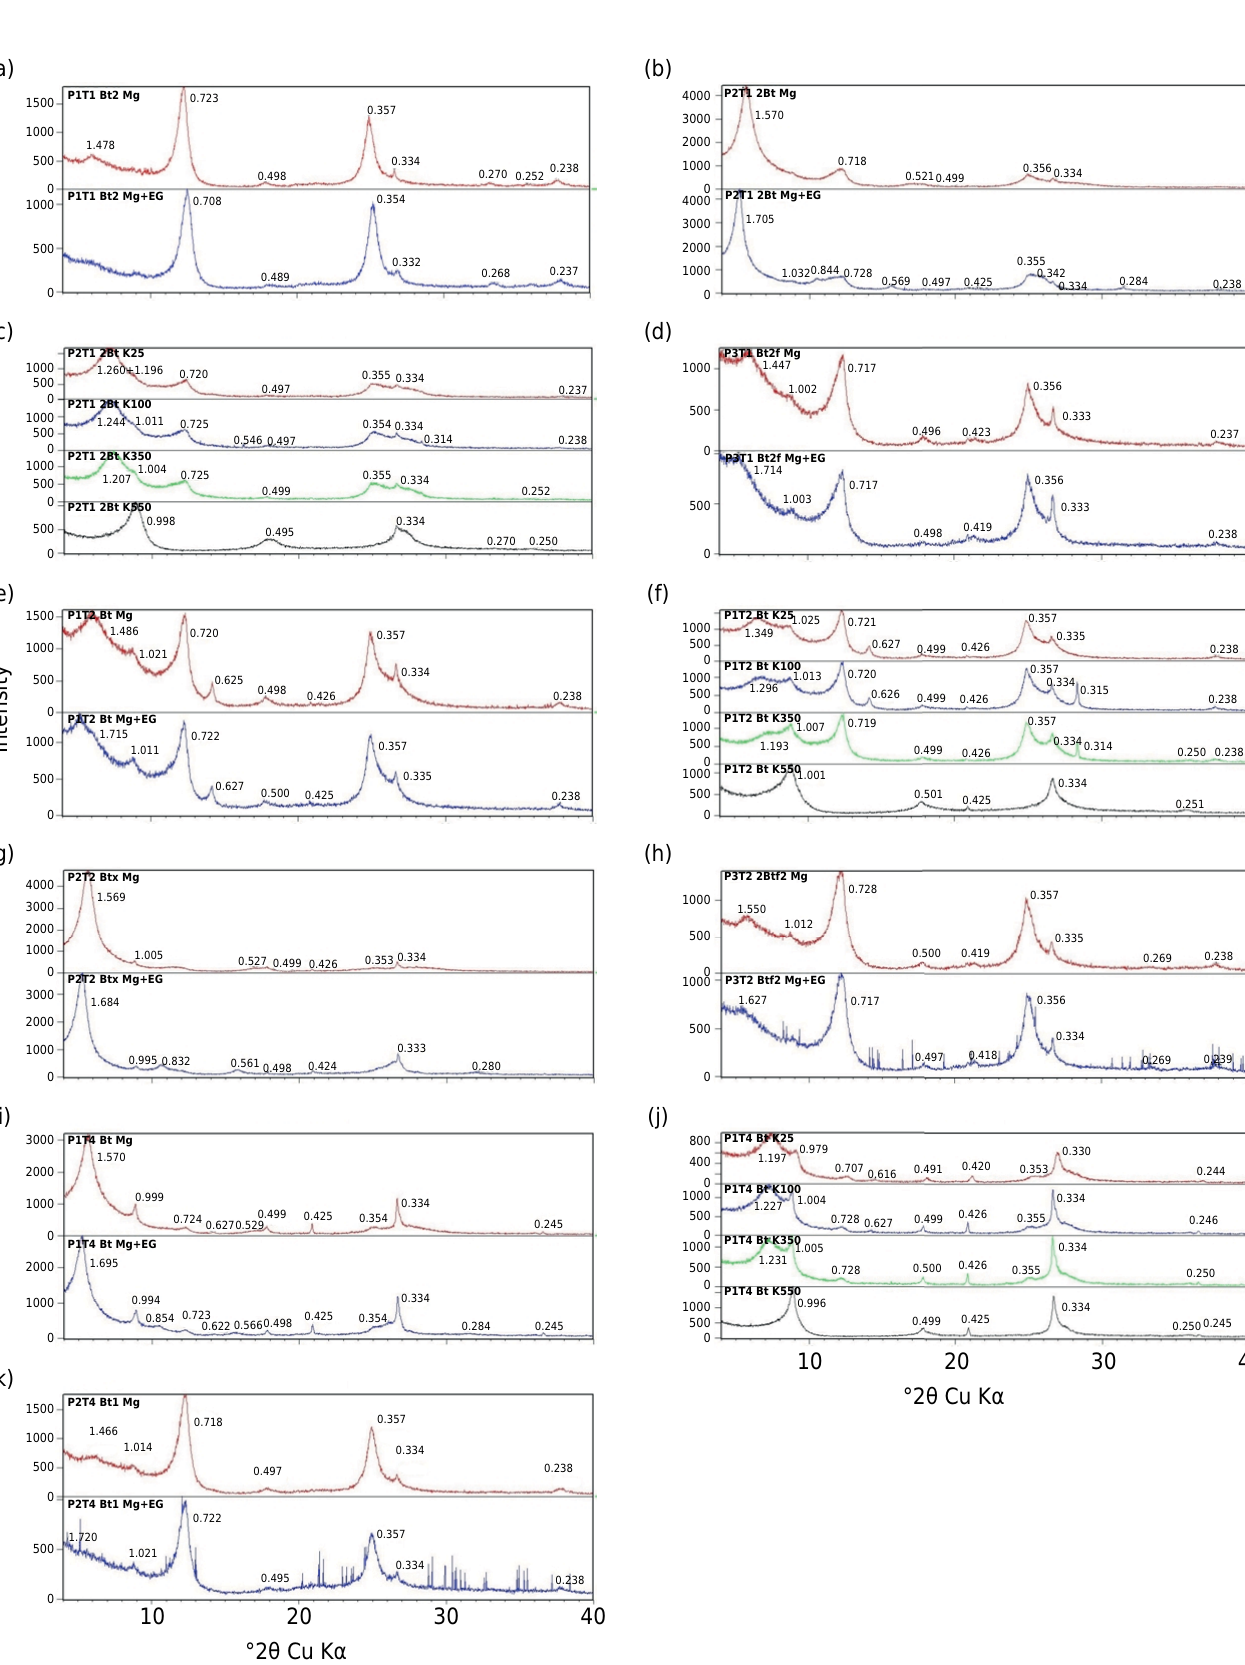
Figure 5. X-ray diffractograms of the clay fraction of horizons B of the studied soil profiles. Samples subjected to saturation treatment with magnesium (Mg) and magnesium saturated with ethylene glycol vapor (Mg+EG): (a) P1T1-Bt2, (b) P2T1-2Bt, (d) P3T1-Btf2, (e) P1T2-Bt, (g) P2T2-Btx, (h) P3T2-2Btf2, (i) P1T4-Bt and (k) P2T4-Bt1. Samples subjected to potassium saturation treatment at different heating levels, room temperature (K25), at 100 °C (K100), 350 °C (K350) and 550 °C (K550): (c) P2T1-2Bt, (f) P1T2-Bt and (j) P1T4-Bt. Nanometer